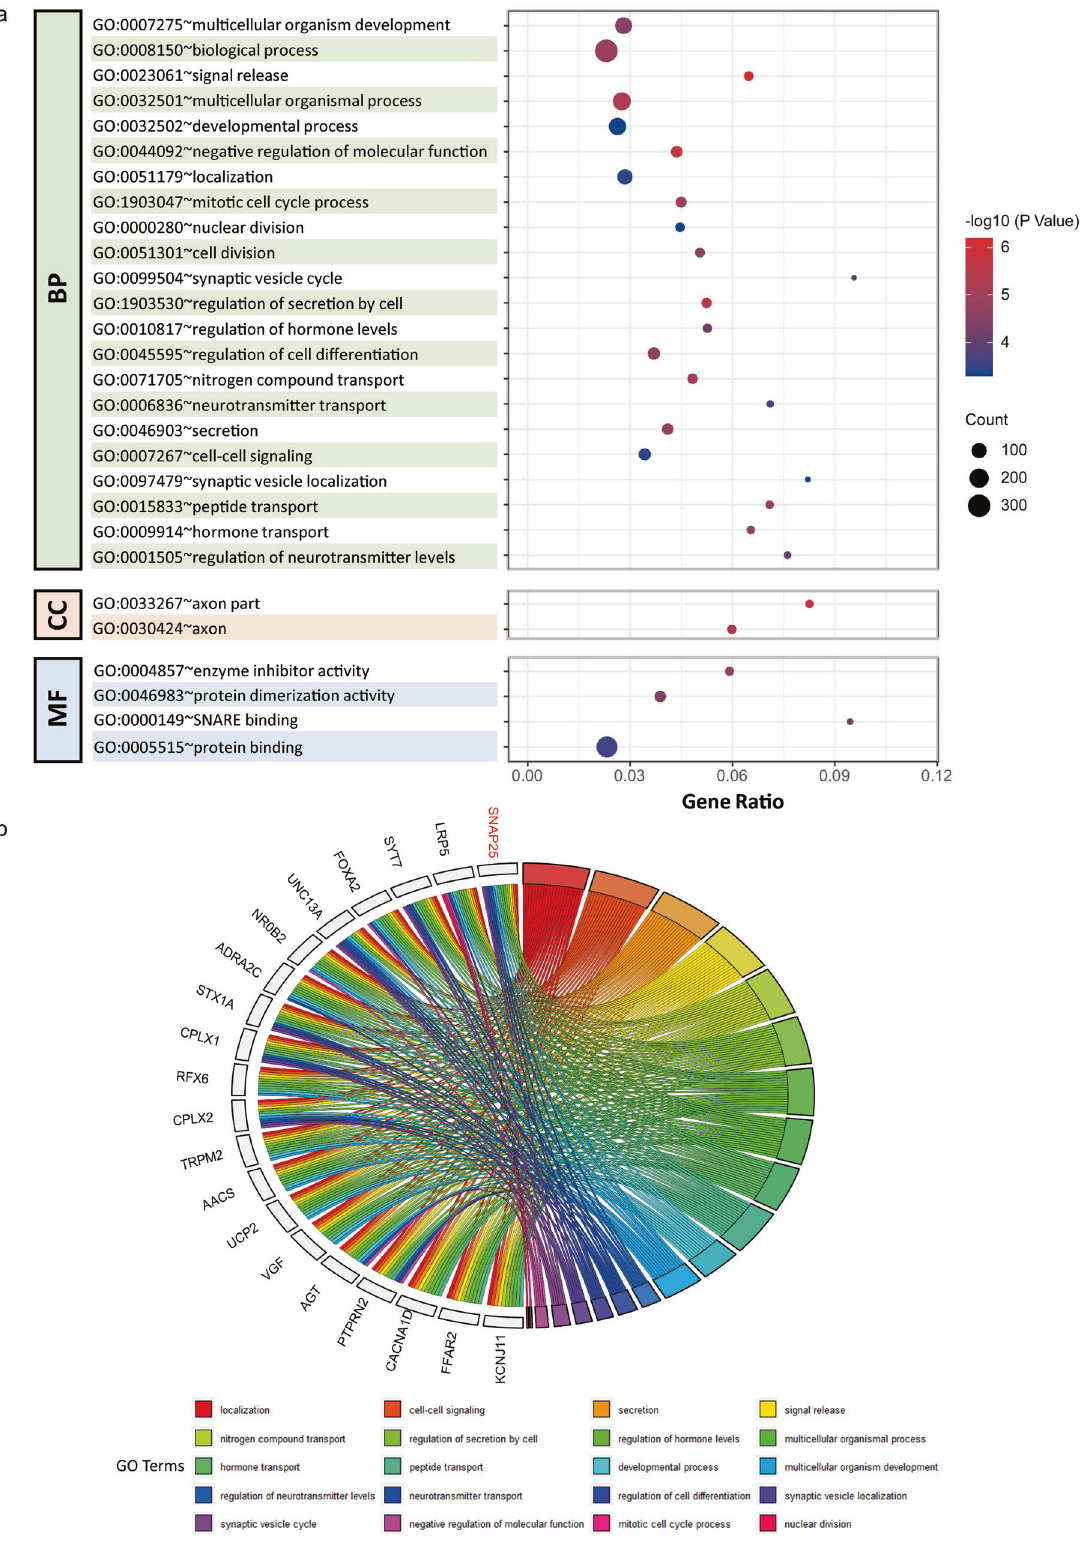
Fig. 1 Functional enrichment pattern of DEGs in GNEC patient samples. a Gene Ontology functional enrichment analysis of DEGs in GNEC. In all, 28 GO terms were found to be signi fi cantly enriched. b Twenty enriched GO Terms in the category of Biological Process (except that with the highest hierarchy GO:0008150) were processed using a GOChord plot. Common genes (found in at least ten GO terms) are shown here on the left side of the circular plot, while enriched GO terms are shown on the right side.